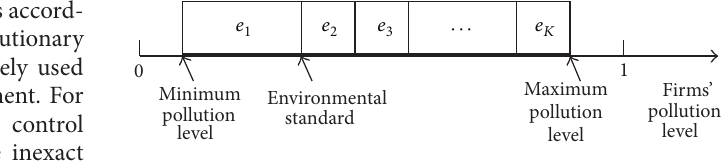
Figure 1: Firms’ pollution emission